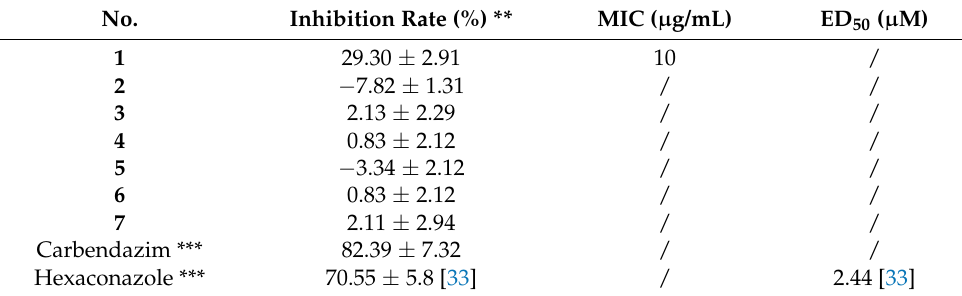
Table 2. Anti- Rhizoctonia solani activity of compounds 1 – 7 in Vitro